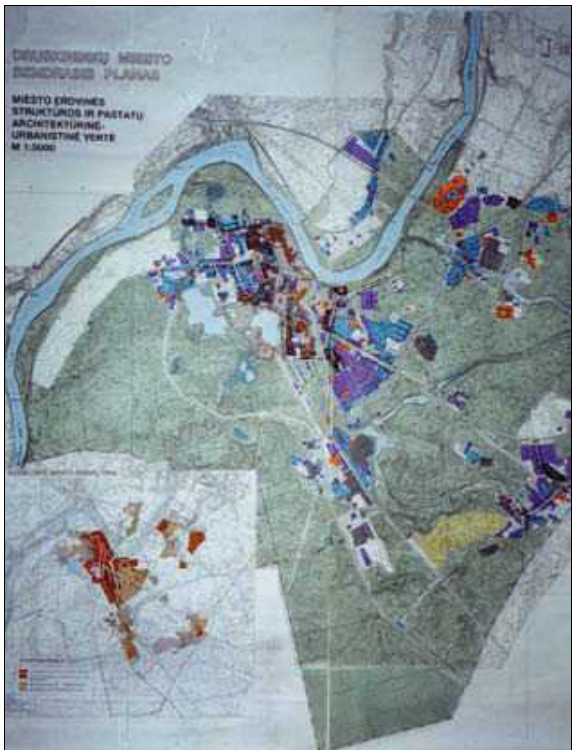
Fig. 9. Master Plan of Druskininkai (executive: